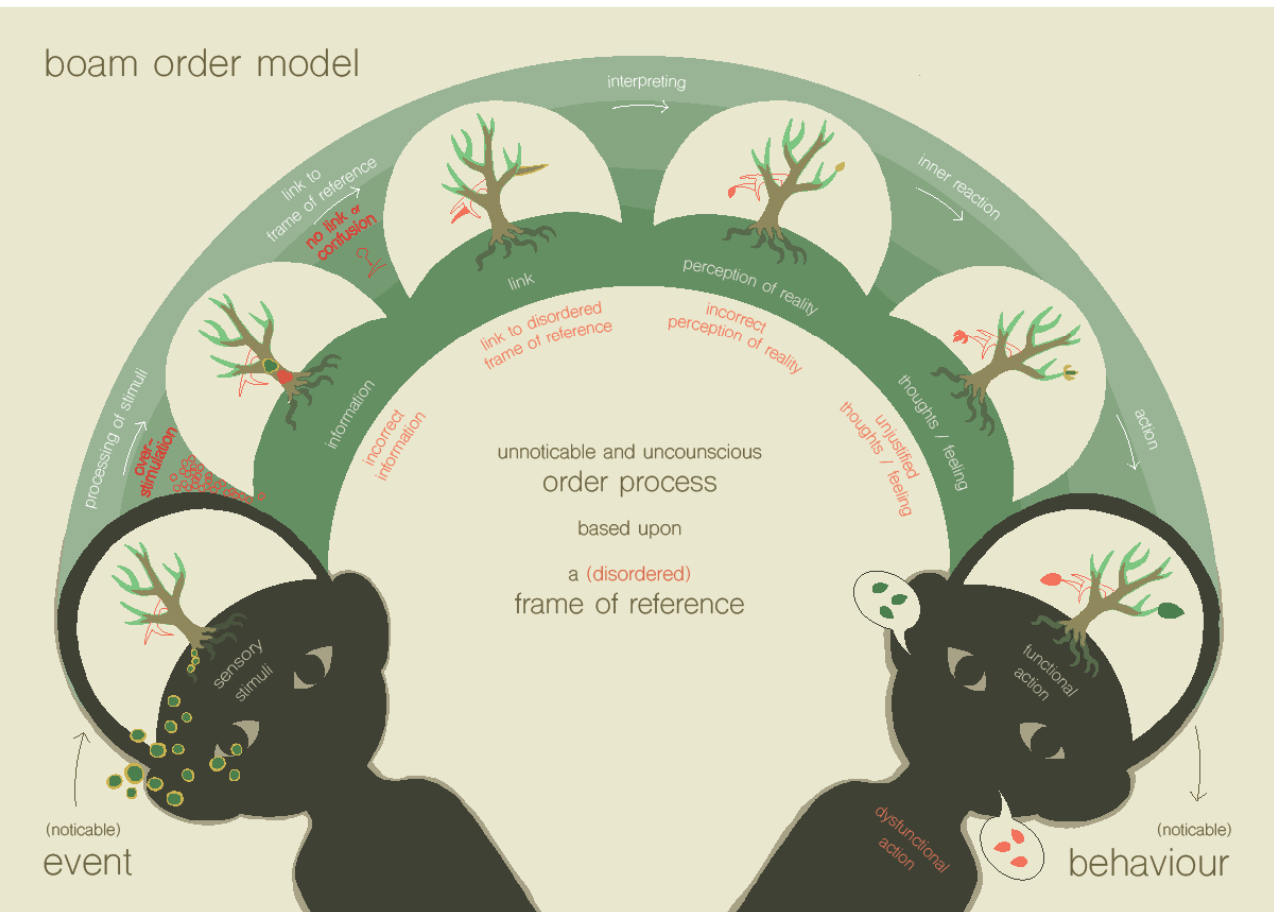
Figure 2. The BOAM order model, depicting the process of ordering stimuli (Truijens, in prep.).